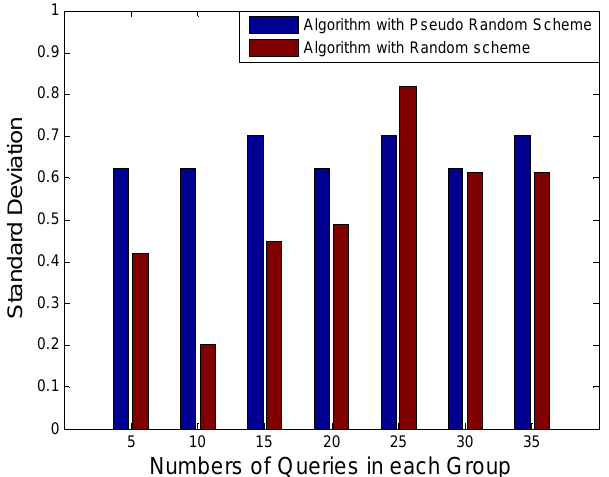
Figure 9. Computing standard deviation of camera activation times for each group of the